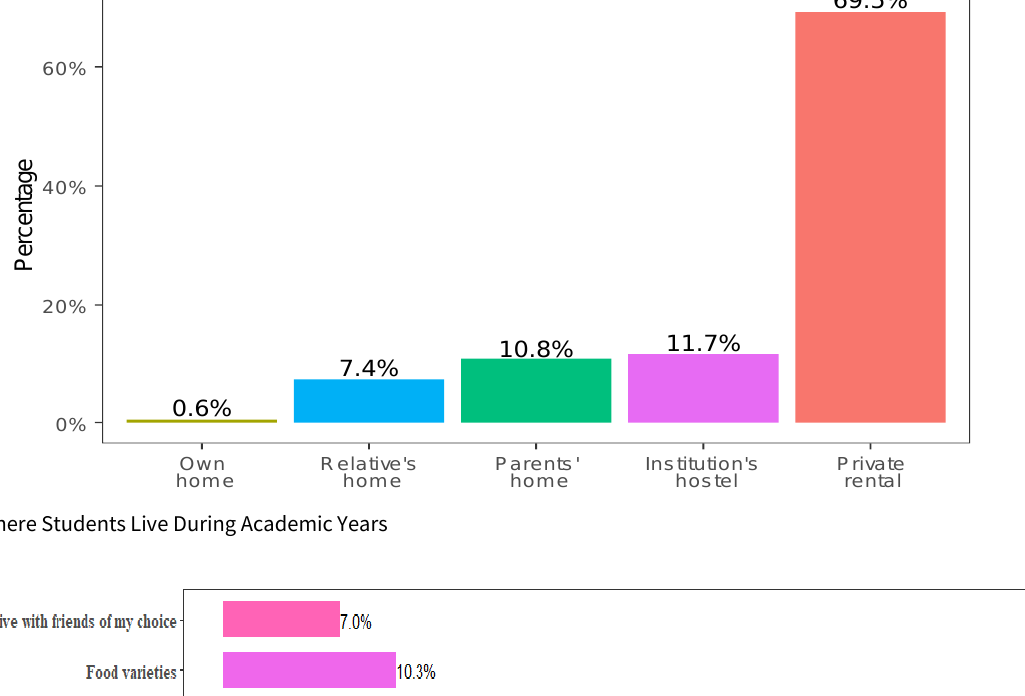
Figure 3. Where Students Live During Academic Years